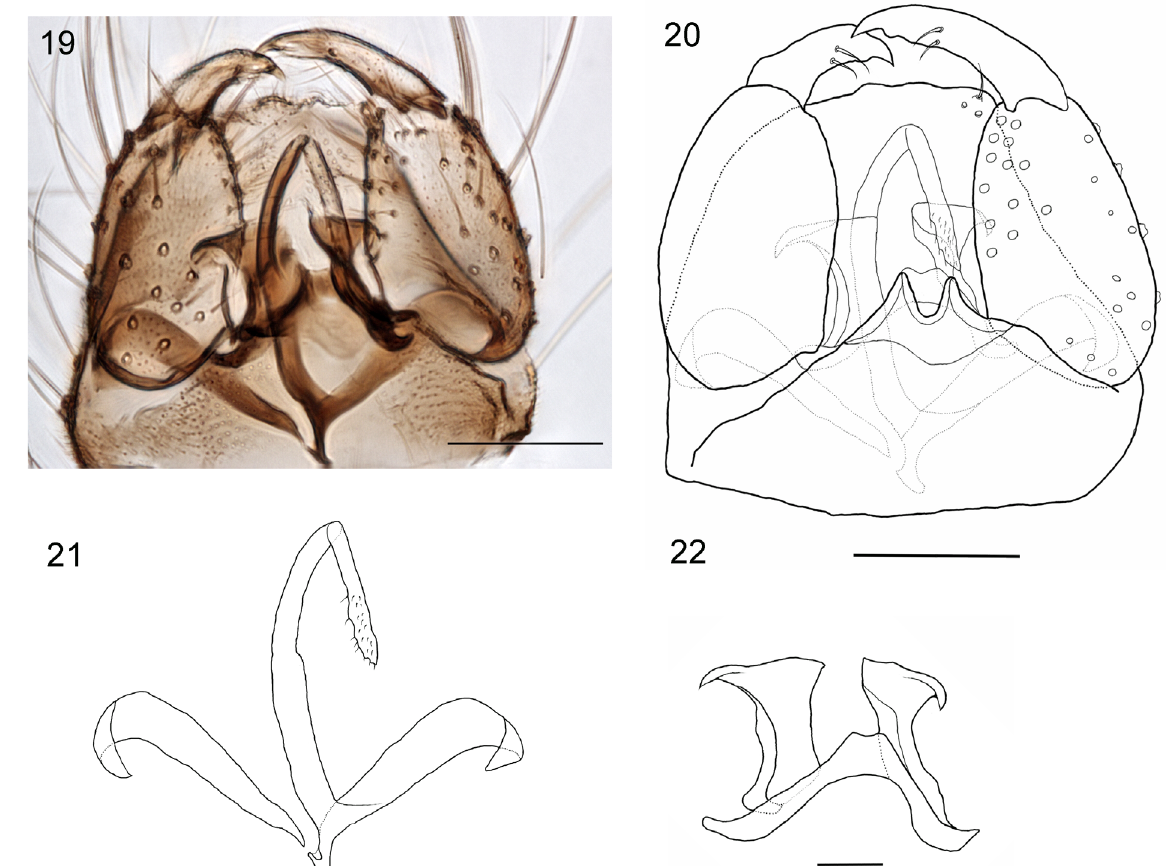
Figs 19–22. Dasyhelea gothlandica sp. nov., holotype, ♂. 19–20 . Ventral aspect of genitalia. 21 . Parameres. 22 . Aedeagus. Scale bars: 19–20 = 50 µm; 21–22 = 16